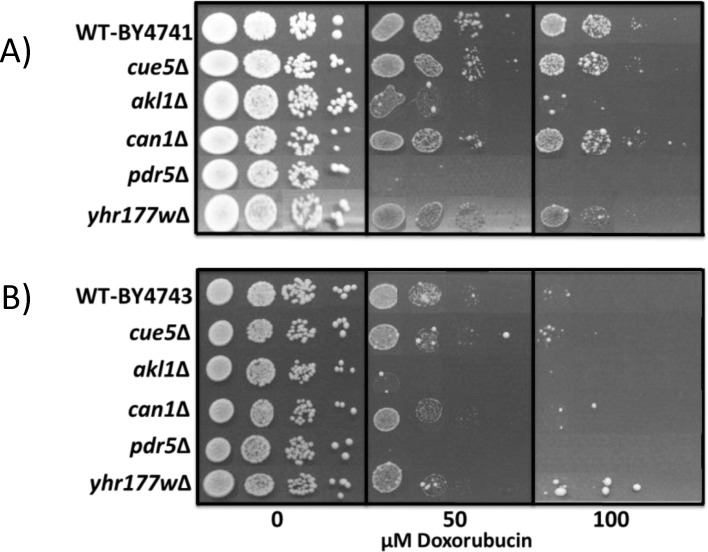
Spotting assays for sensitivity analyses.
(A) Haploid and (B) diploid deletion mutants of the candidate genes were analyzed by a spotting assay for their doxorubicin sensitivity. Serial dilutions (5 μl) (OD600 0.2, 0.02, 0.002 and 0.0002) for each strain were used for the sensitivity analyses.